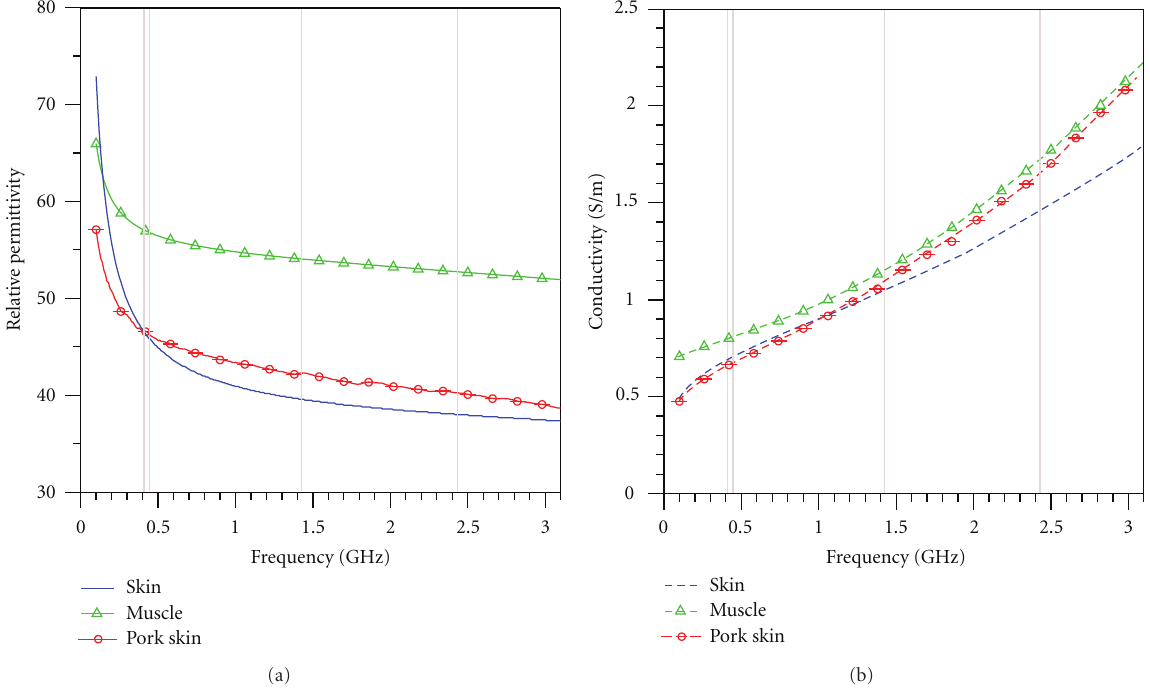
Figure 8: Comparison of human skin, human muscle, and pork skin: (a) relative permittivity and (b)